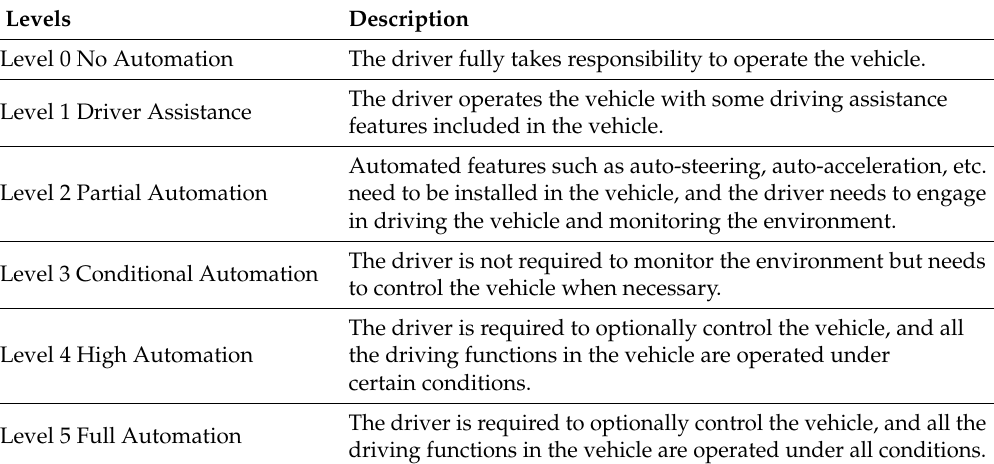
Table 1. Six levels of the autonomous driving technology.